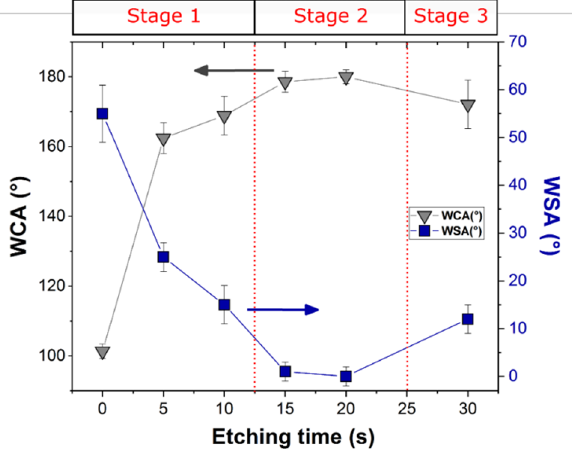
Figure 5. Water contact angles and sliding angles of aluminum alloy surfaces etched at different times after silanization.